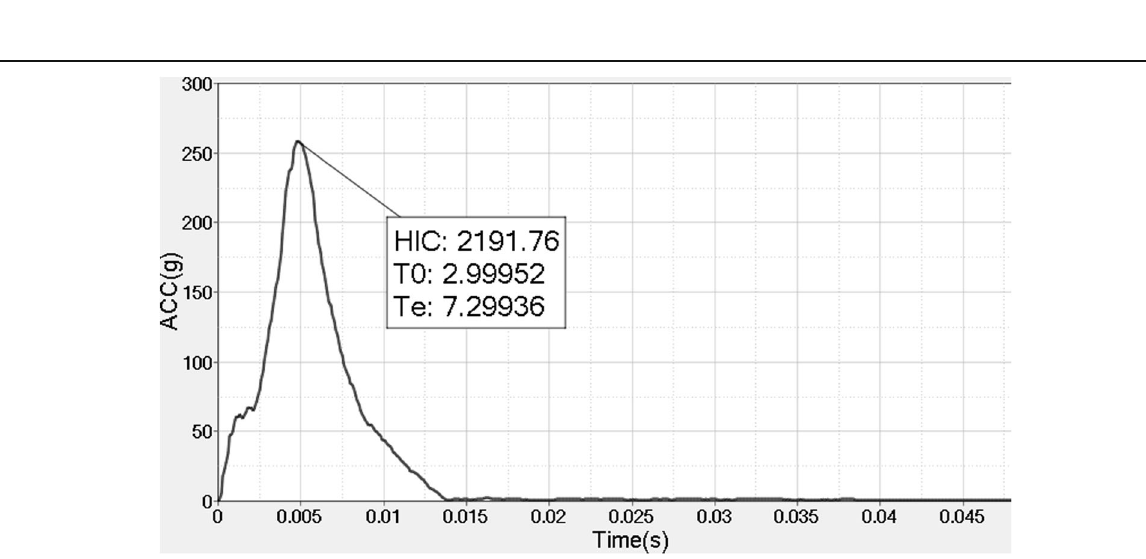
Fig. 13 The result of head injury value without the airbag protection at the opening angle of 60°